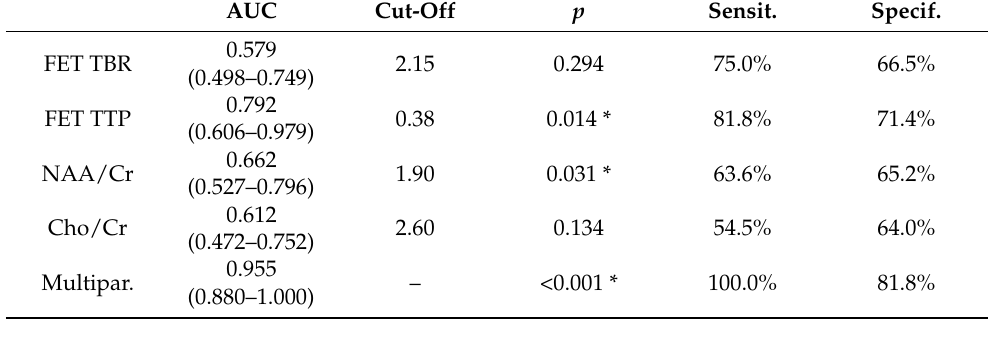
Table 3. Diagnostic accuracy of MRS and PET parameters for differentiation between glioblastoma and non-glioblastoma. Significant results are marked with an asterisk.